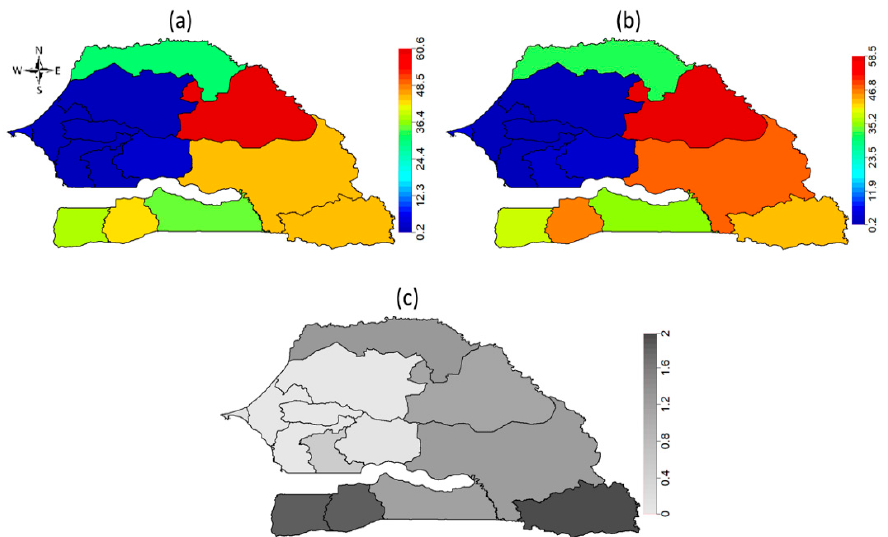
Figure 5. Observed prevalence ( a ), predicted posterior prevalence ( b ), and posterior standard deviation ( c ) of Senegalese 0–14 year old girls’ FGM/C. Deep blue to red corresponds to low to high prevalence. Light to dark grey colours correspond to increase in uncertainty of estimation. Evidence from 2017 SDHS (Model 3).